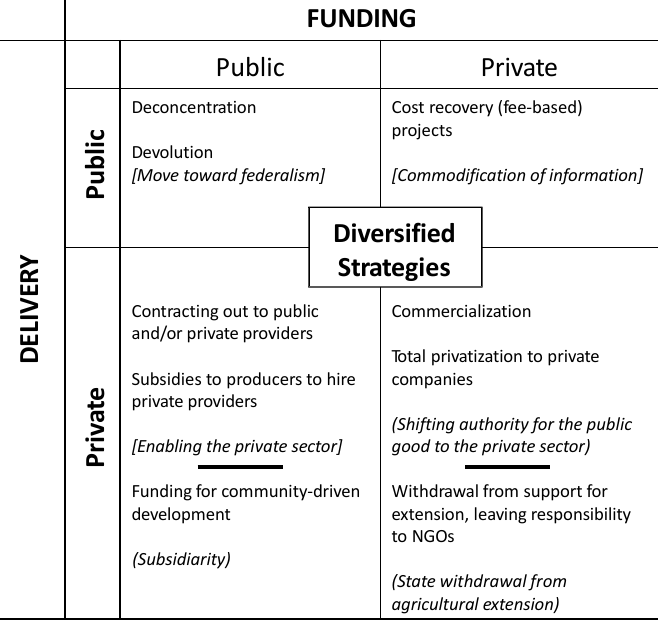
Figure 3. Influence of program financing on operational strategy